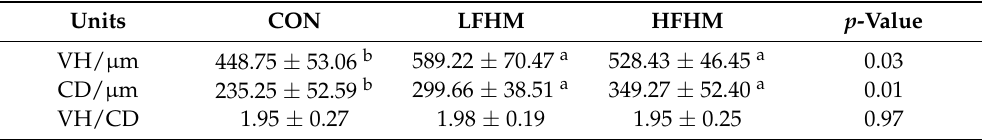
Table 5. Effects of different amounts of fermented Chinese herbal medicine on the morphological structure of jejunum in weaned piglets.